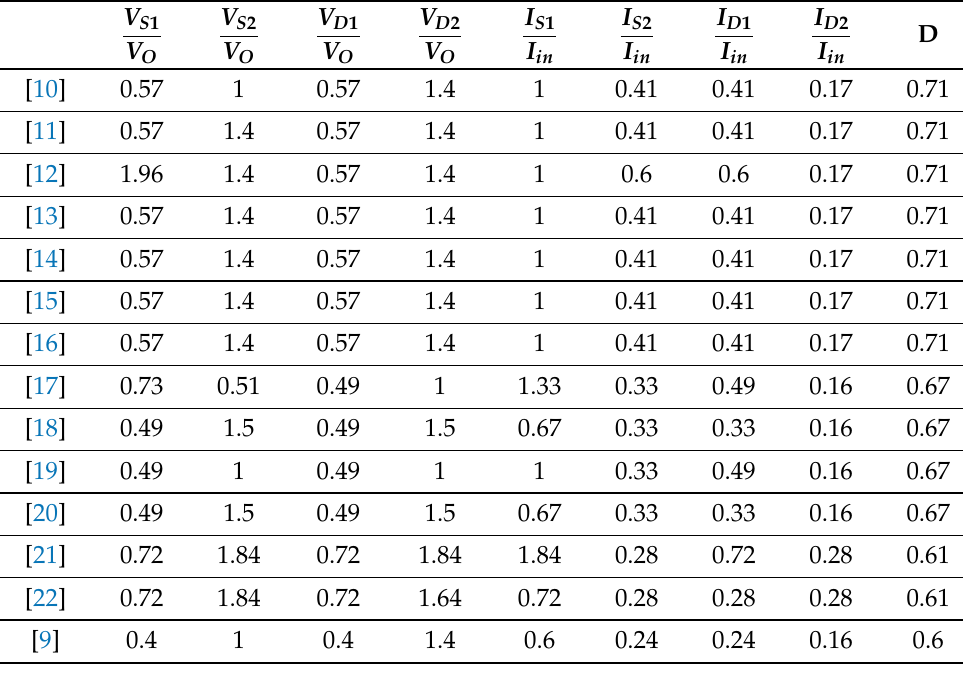
Table 1. Comparison of the voltage/current